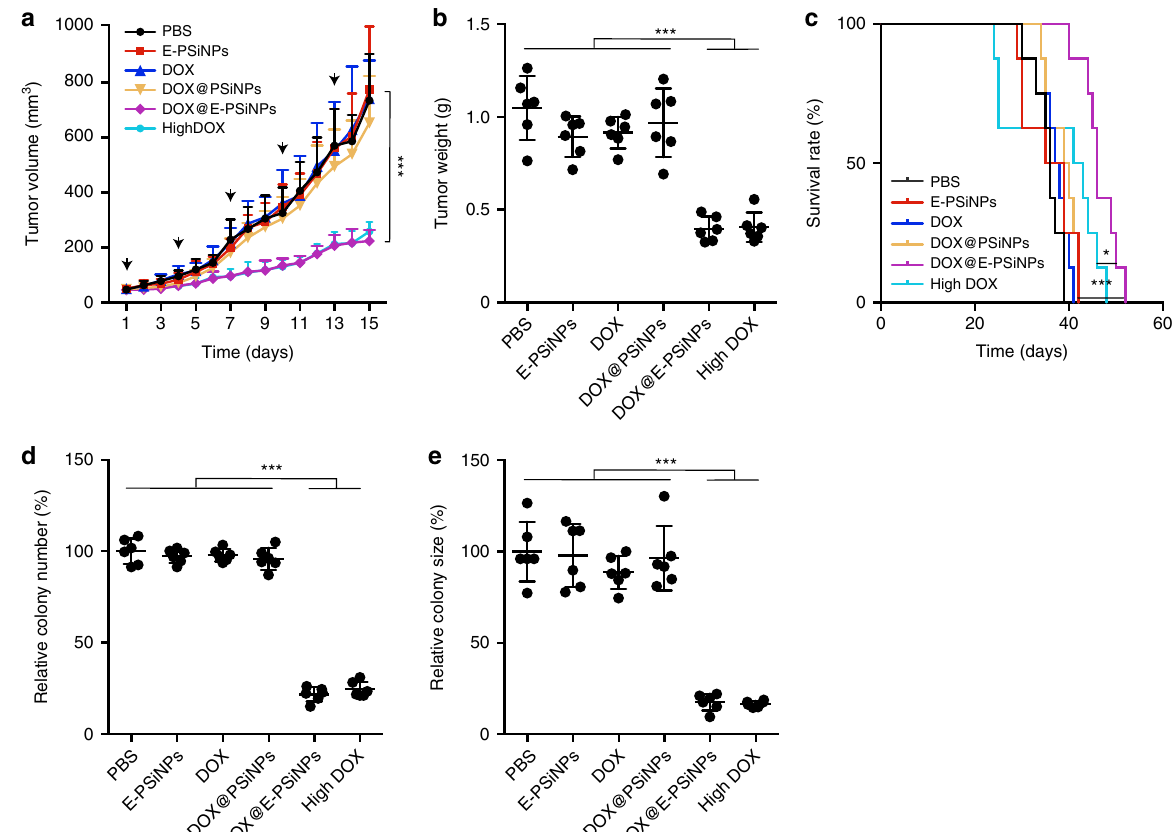
Fig. 8 Anticancer activity of DOX@E-PSiNPs in orthotopic 4T1 tumor-bearing mice. a Tumor growth curves of orthotopic 4T1 tumor-bearing mice after intravenous injection of PBS, E-PSiNPs, free DOX, DOX@PSiNPs, DOX@E-PSiNPs exocytosed from H22 cells at DOX dosage of 0.5 mg kg − 1 , or free